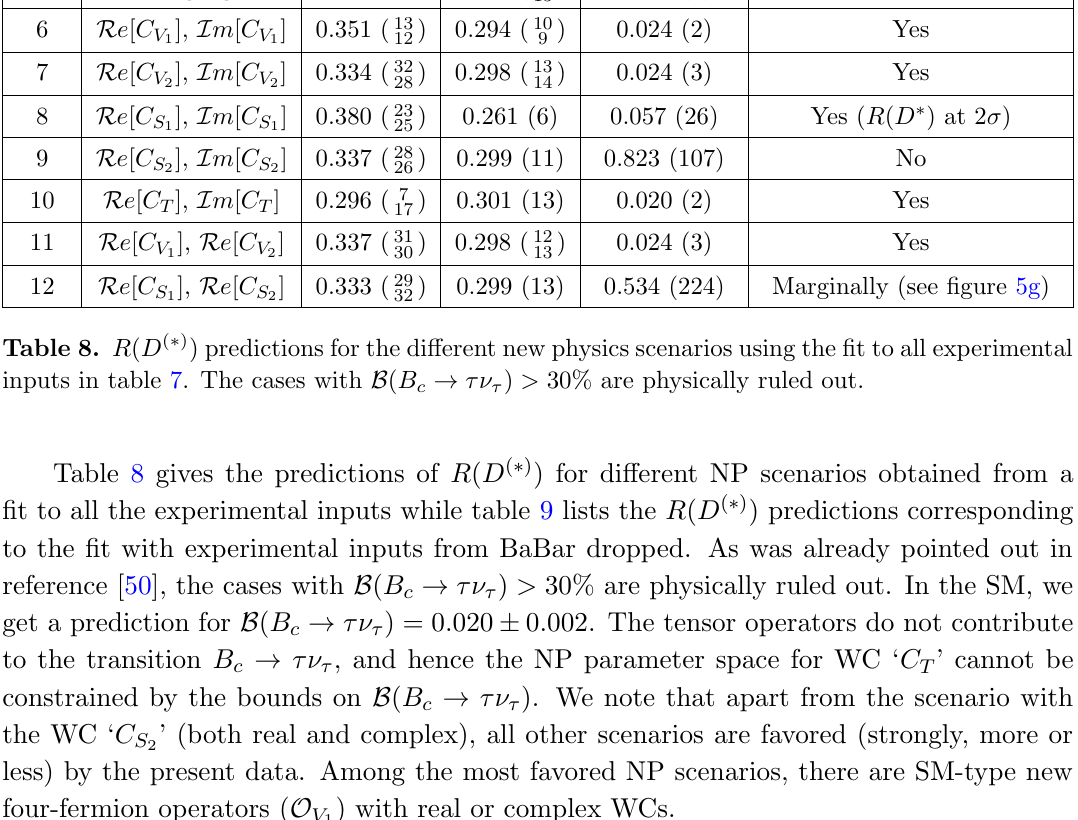
Table 8 gives the predictions of R ( D ( (cid:3) ) ) for di(cid:11)erent NP scenarios obtained from